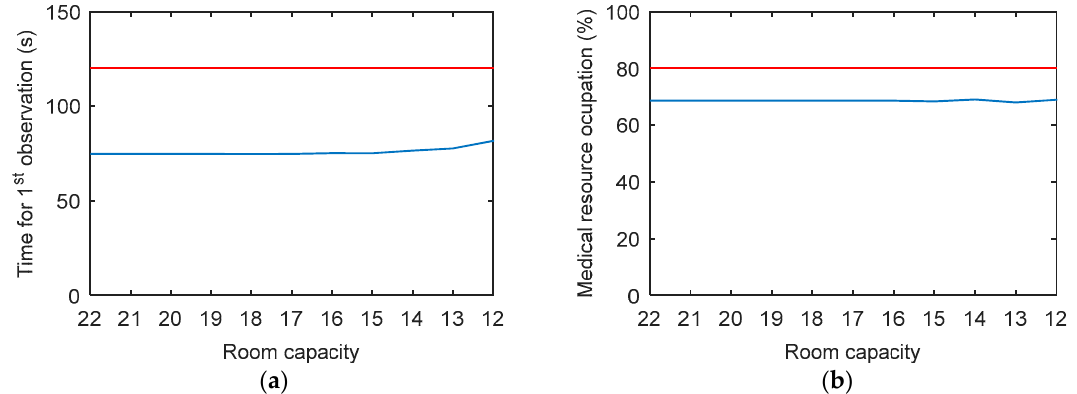
Figure 12. Obtained values for different capacity scenario: ( a ) waiting time for first medical intervention (blue line — simulation model, red line — Manchester time); ( b ) medical resource occupation (blue line — simulation model, red line — occupation rate limit).